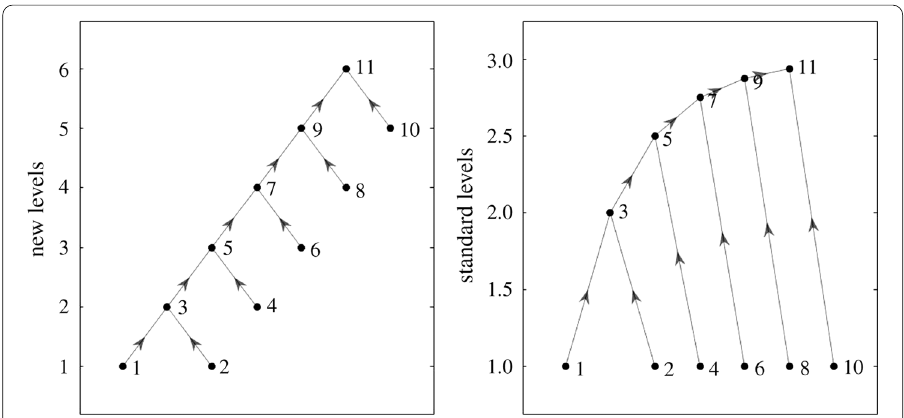
Fig. 3 Generalised trophic level vs Original notion This figure illustrates a comparison between the generalised notion of trophic levels and the original, taken from (MacKay et al.